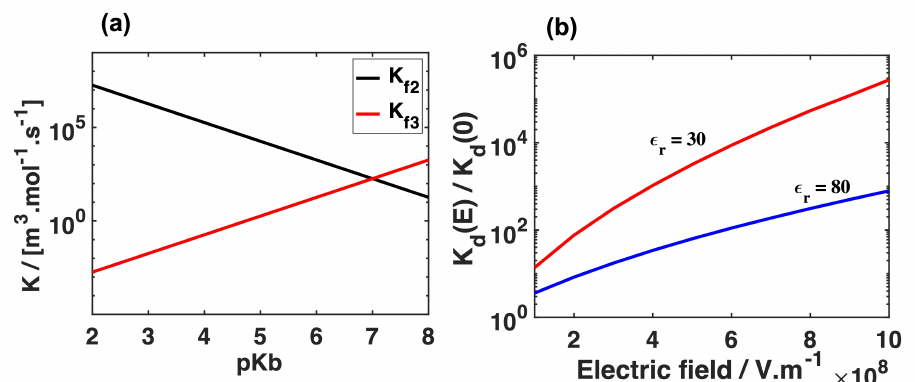
Figure 9. ( a ) pK b dependent rate constant for protonation and deprotonation of a weak base group at the BPM interface. At pK a = 7, the protonation and deprotonation rate constant is equal. The K f 2 and K f 3 indicate the forward rate constant of protonation and deprotonation reaction of the neutral base; ( b ) the electric field influenced rate constant at different dielectric constants of water.